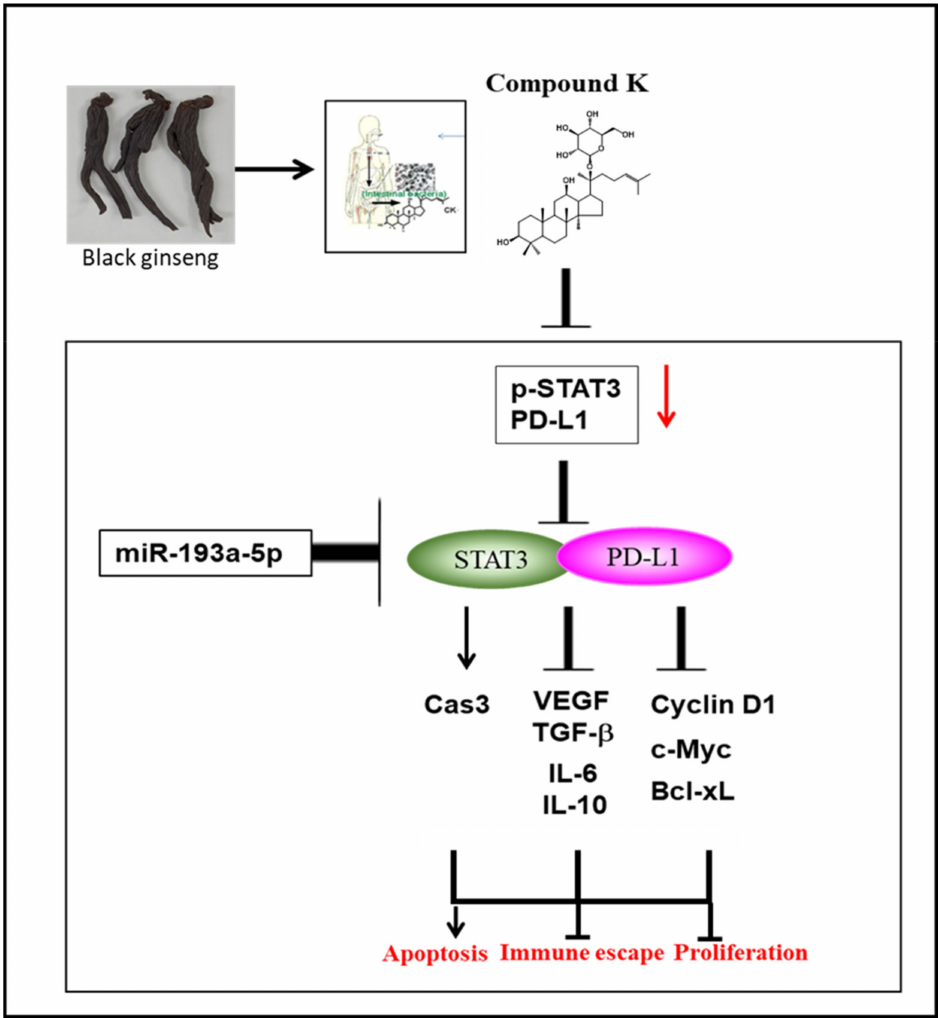
Figure 9. Schematic diagram of the apoptotic effect of compound K via the activation of miR193a-5p and inhibition of STAT3/PD-L1